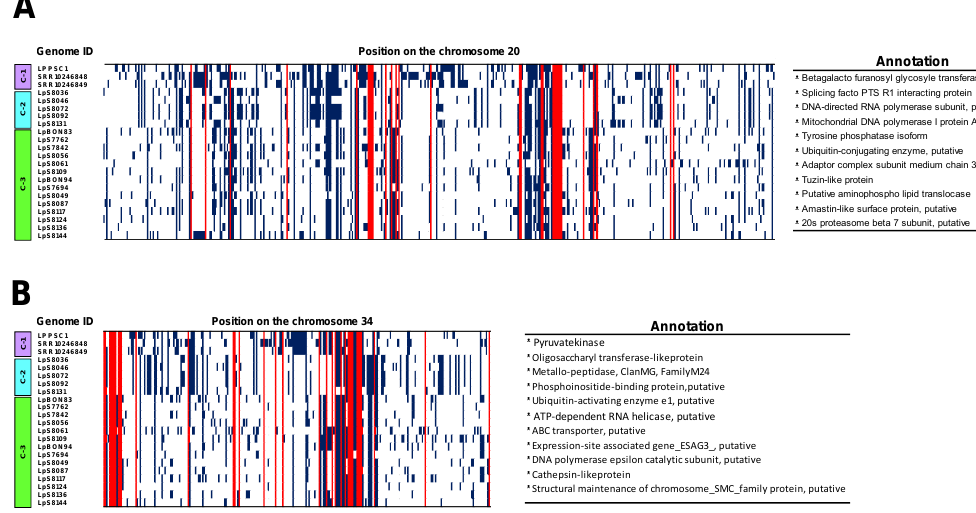
Figure 5. Overview of the SNPs identification results in chromosomes 20 and 34 of each genome analyzed. SNPs identified along chromosome 20 ( A ) and chromosome 34 ( B ). The dark blue line represents the presence of a SNP through each chromosome and the red line the location of shared SNPs among all genomes analyzed. The table on the right of each figure shows the annotation of the main genes with SNPs shared among three clades identified in this study.